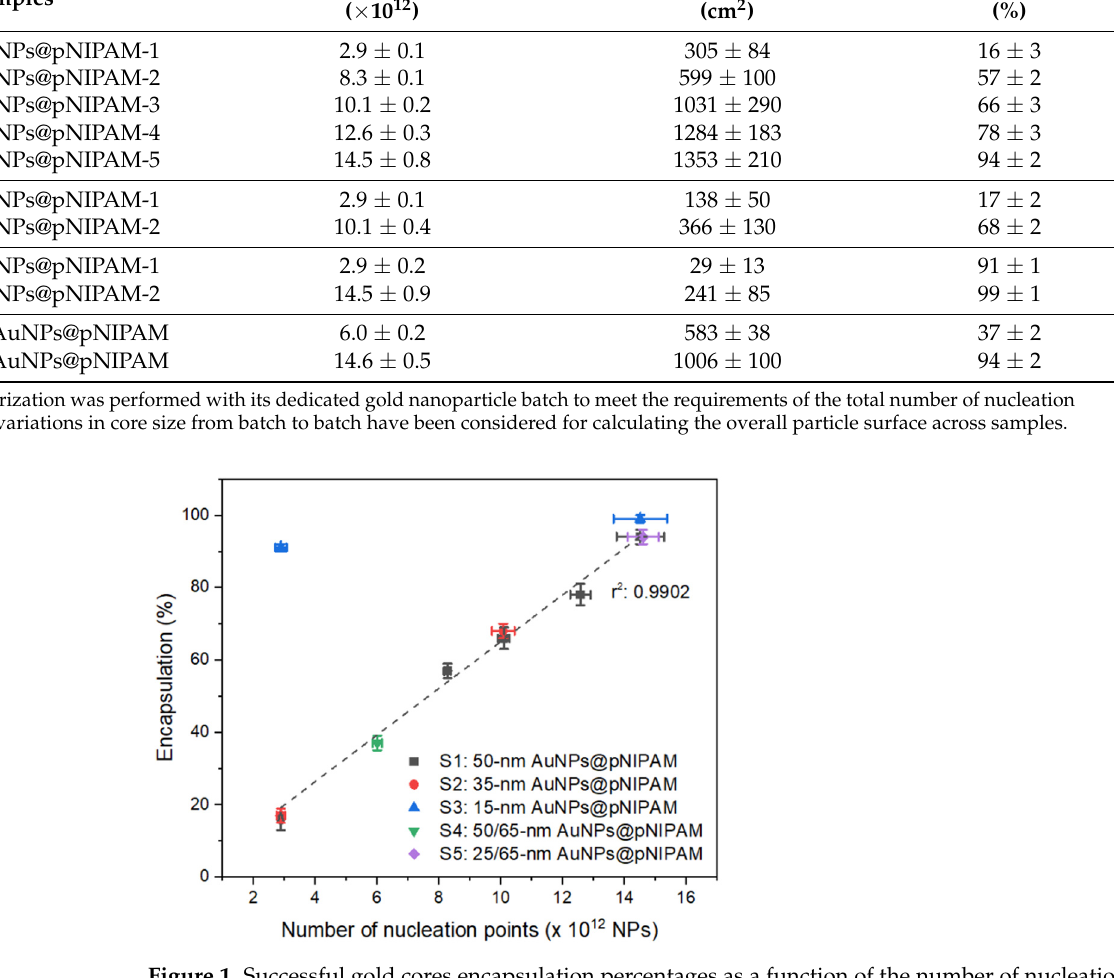
Table 1. Summary of the performed syntheses and their resulting successful encapsulation yields ‡ . Samples